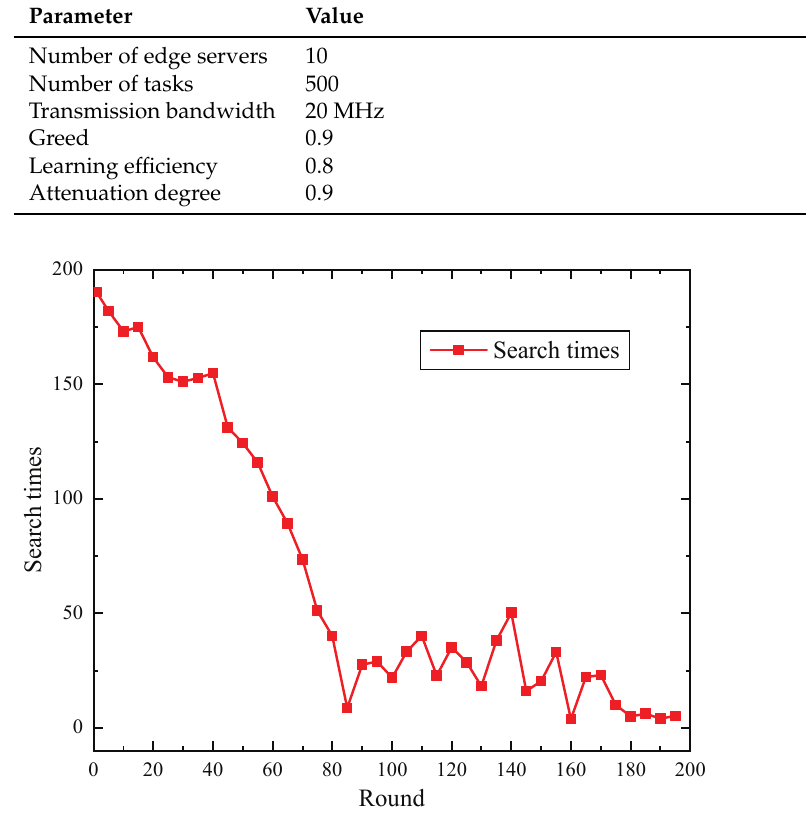
Figure 3. Change diagram of search times of edge